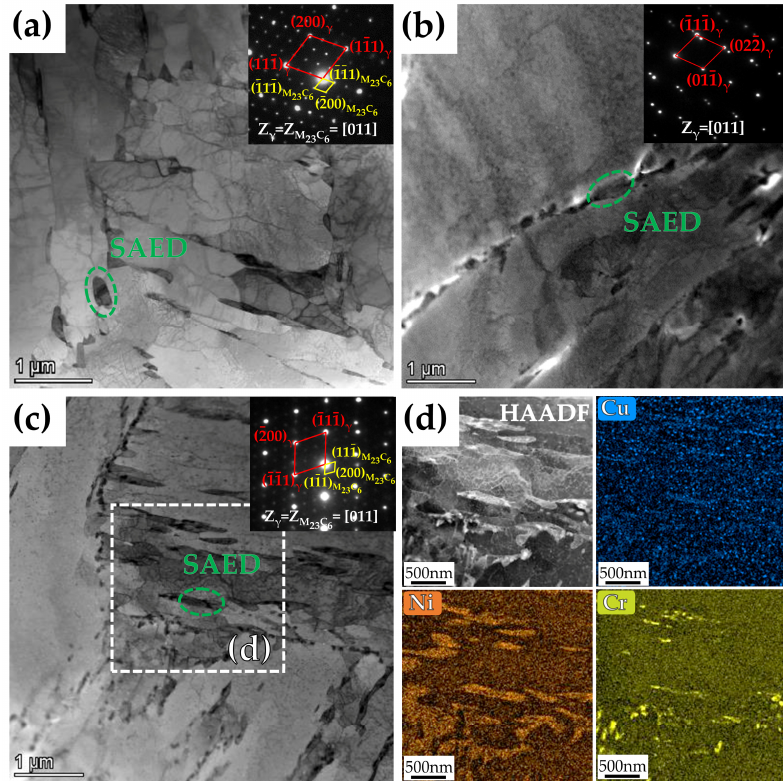
Figure 9. Bright field TEM images and the corresponding electron ‐ diffraction analysis from the selected area of the three steels with different Cu content tempered at 600 °C for 2 h: ( a ) 0Cu ‐ steel, ( b ) 1Cu ‐ steel, and ( c ) 3Cu ‐ steel. ( d ) The HAADF ‐ STEM images and EDS mappings of Cu, Ni, and Cr corresponding to the white region in ( c ). The APT results of 3Cu ‐ steel tempered at 600 °C for 2 h are displayed in Figure 10. The segregation of Cu, Ni, and Mn atoms from the volume can be clearly observed. Based on the TEM results, the Ni ‐ rich region can be identified as reversed austenite. Segregation of Mn atoms and Cu atoms formed as Cu ‐ rich precipitates were found located in the reversed austenite. It can be observed from Figure 10b that the concentrations of Ni, silicon (Si), Mn, and Cu increased significantly from the martensite matrix to the reversed austenite. Figure 11a displays 3 ‐ D atomic probe mappings and 2 ‐ D concentration mappings of Cu and Ni atoms from one of the Cu ‐ rich precipitates displayed in Figure 10a, and the corresponding proximity histogram is displayed in Figure 11b. From the histogram, it can be calculated that the concentration of Cu atoms reached nearly 100 at.% in the core of the precipitate. The concentration of Ni decreases toward the core of the Cu ‐ rich precipitate. A shell structure of Ni can be clearly observed in Figure 11a. This is in agreement with the work of Wen, Y.R. et al. [30] where the Ni and Mn atoms segregated at the Cu precipitates, forming a core–shell structure in an age ‐ hardened Fe ‐ Cu ‐ based multicomponent ferritic alloy.